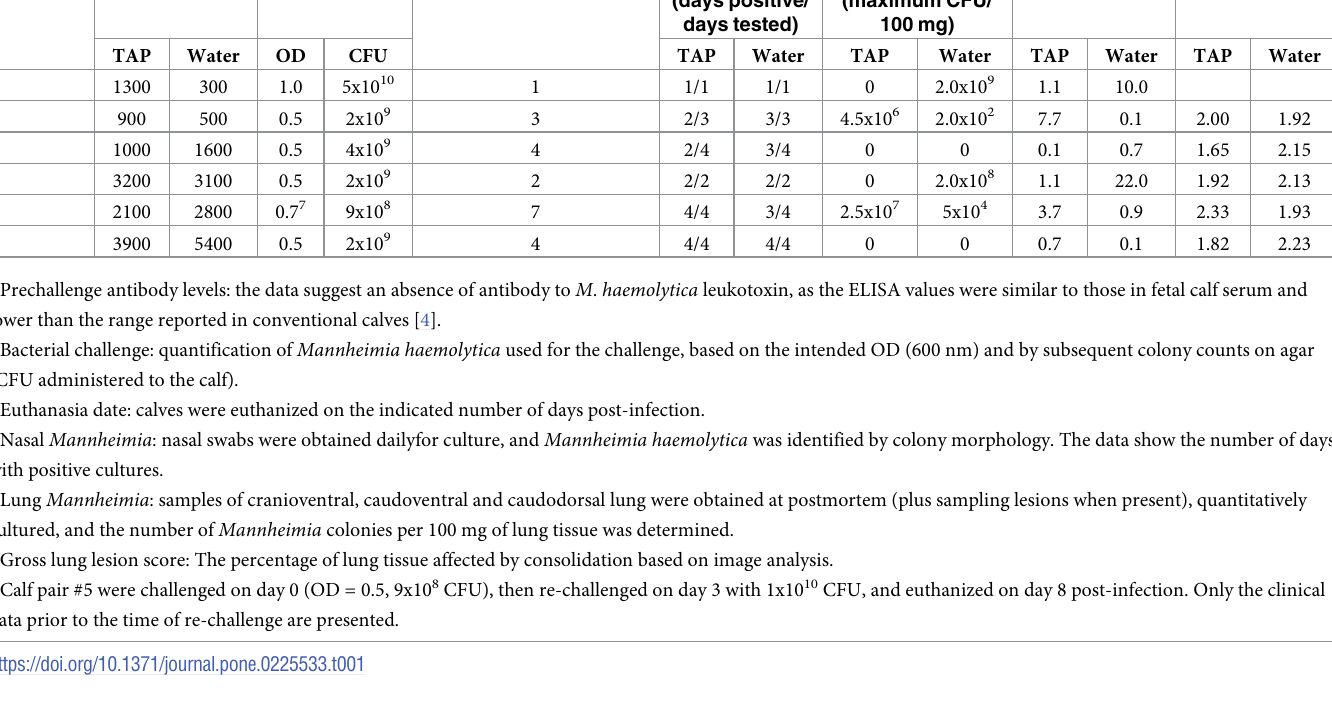
Table 1. Overview of the design and bacteriology and pathology findings of the in vivo experiment. Calf pair Prechallenge antibody level